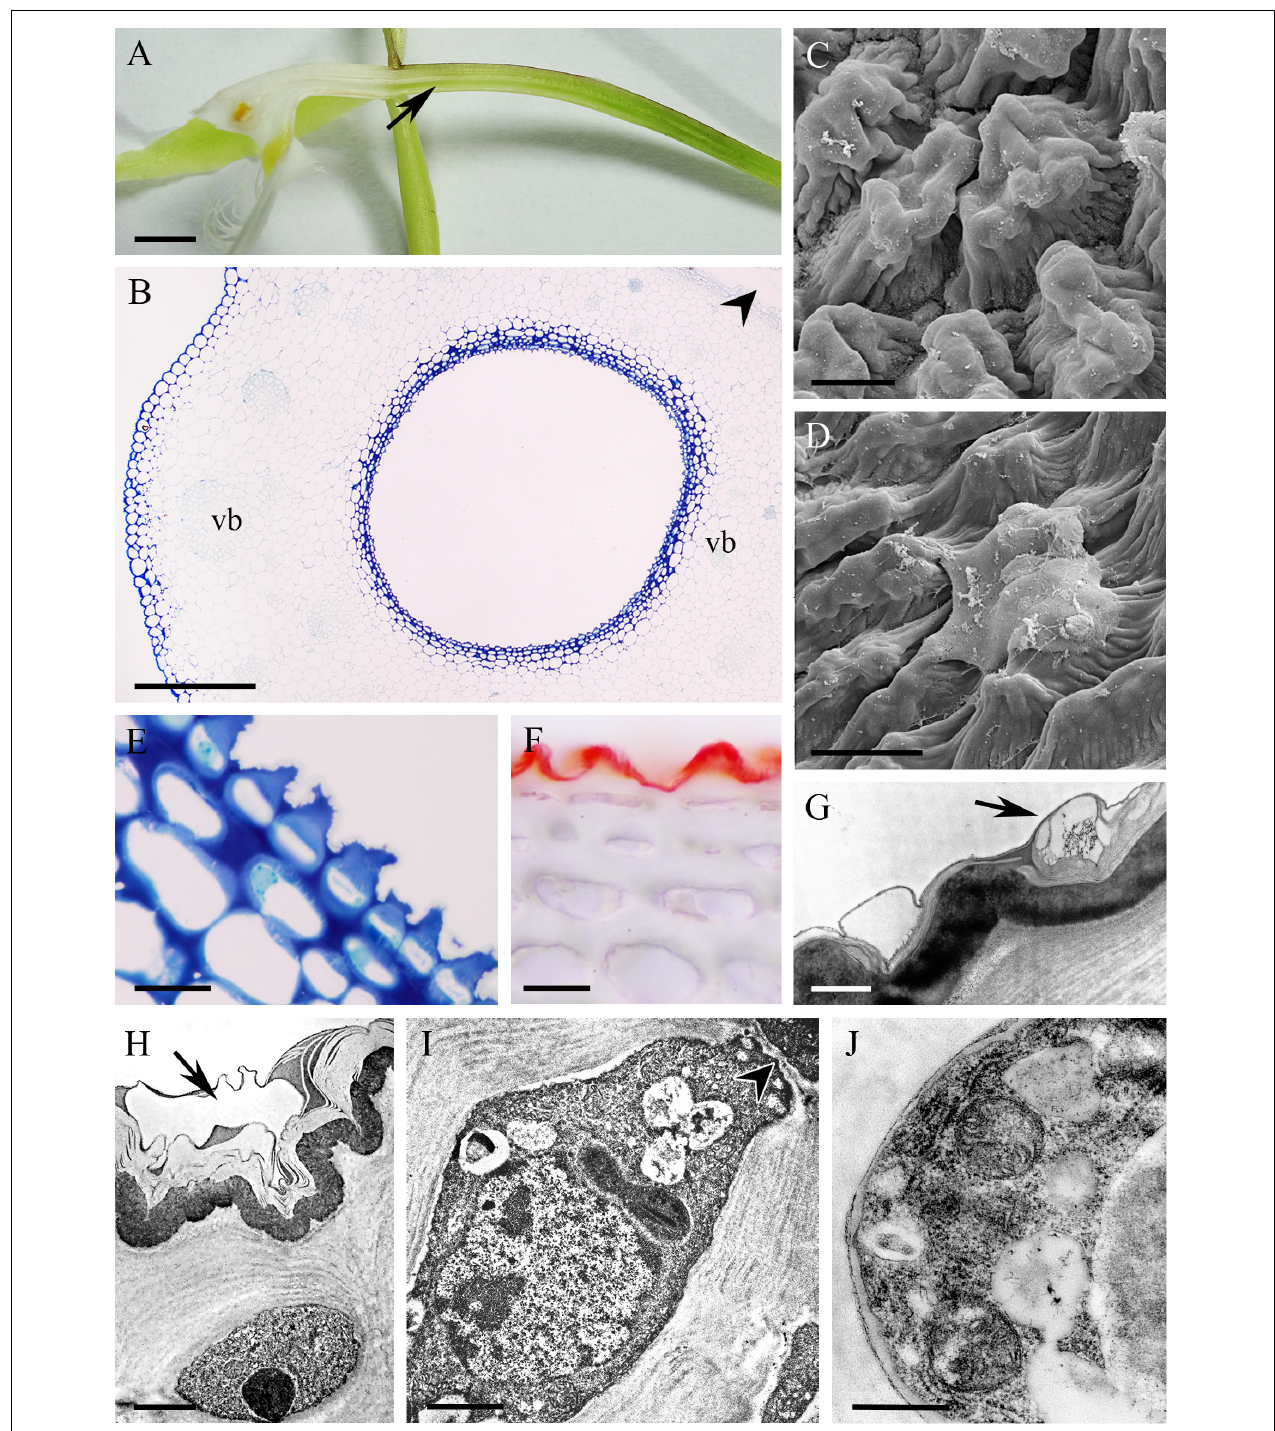
FIGURE 7 | Epidendrum ciliare. (A) Longitudinal section of flower. Cuniculus indicated by arrow. (B) Transverse section of ovary with cuniculus and surrounding parenchyma containing vascular bundles (MB/AII). Transmitting tract is indicated by arrowhead. (C) Papillose epidermal cells lining cuniculus. (D) Secretion coating epidermis. (E,F) Epidermis and subepidermal parenchyma of cuniculus (MB/AII and Sudan III, respectively). Note thick tangential cell walls and cellulose projections penetrating cuticle. (G) Cell wall with thick, bilayered cuticle and cuticular blisters containing secretion (arrow). (H) Surface secretion and cuticular blister (arrow) of epidermal cell. (I) Electron-dense protoplast of epidermal cell containing large nucleus, starchless plastid and small vacuoles with flocculent content. Plasmodesmata in anticlinal cell wall marked with arrowhead. (J) Detail of parietal cytoplasm with profiles of ER, mitochondria and secretory vesicles. Scale bars: A = 1 cm; B = 500 µ m; C = 10 µ m; D–F = 20 µ m; G = 1 µ m; H, I = 2 µ m; J = 0.5 µ